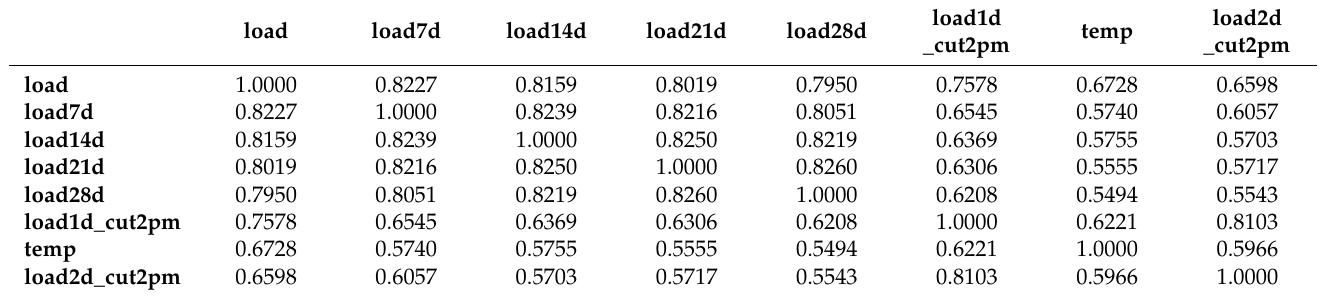
Table A2. Correlation matrix for the first seven features with the highest correlations with the load.